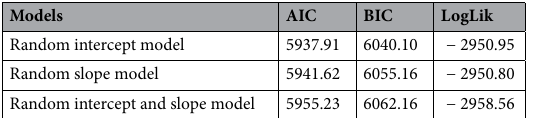
Table 2. Selection of random effect models to be included in linear mixed effect